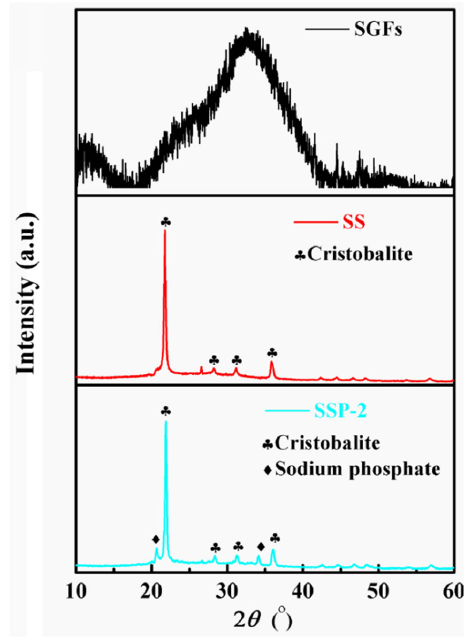
Figure 5. XRD patterns of SGFs, SS, and SSP ‐ 2 fired at 850 °C for 30 min. FTIR patterns of samples SS and SSP ‐ 2 fired at 850 °C were shown in Figure 6. Com ‐ pared with the FTIR spectrum of the residue of sample SS, a new absorption band ap ‐ peared at 895 cm − 1 in the spectra of the residue of sample SSP ‐ 2, which attributed to the asymmetric stretching modes of the P ‐ O ‐ P bonds [19,33]. Furthermore, compared with the FTIR spectrum of the residue of sample SS, these peaks at 795 and 620 cm − 1 became stronger in the FTIR spectrum of the residue of sample SSP ‐ 2, representing an increase in cristobalite crystals content [17]. These results coincide with the above ‐ mentioned analysis of XRD.